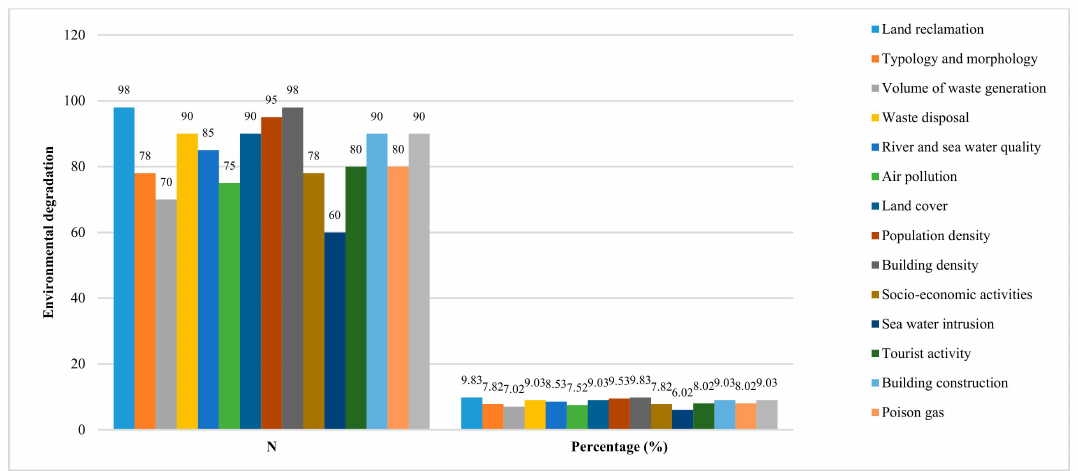
Figure 14. Decreasing environmental quality in the new city area of Metro Tanjung Bunga. Source: Primary data and analysis